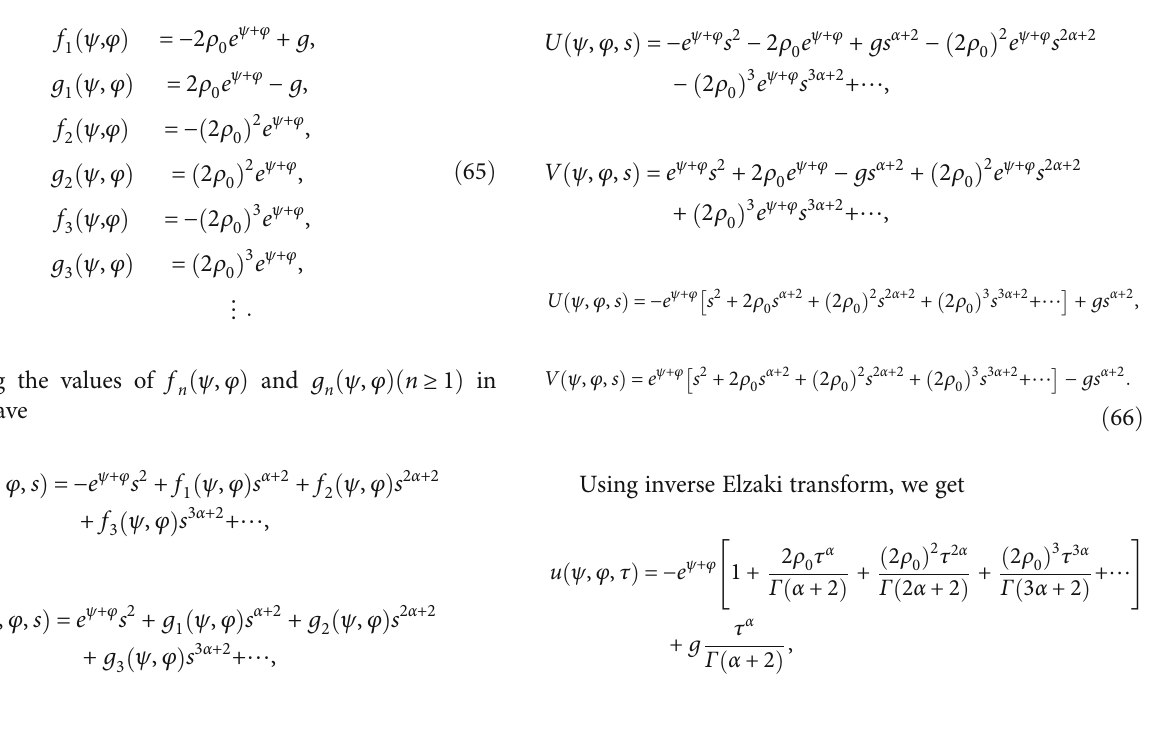
Figure 12: The fractional order of α = 0 : 8 and 0 : 6 of Problem 4.